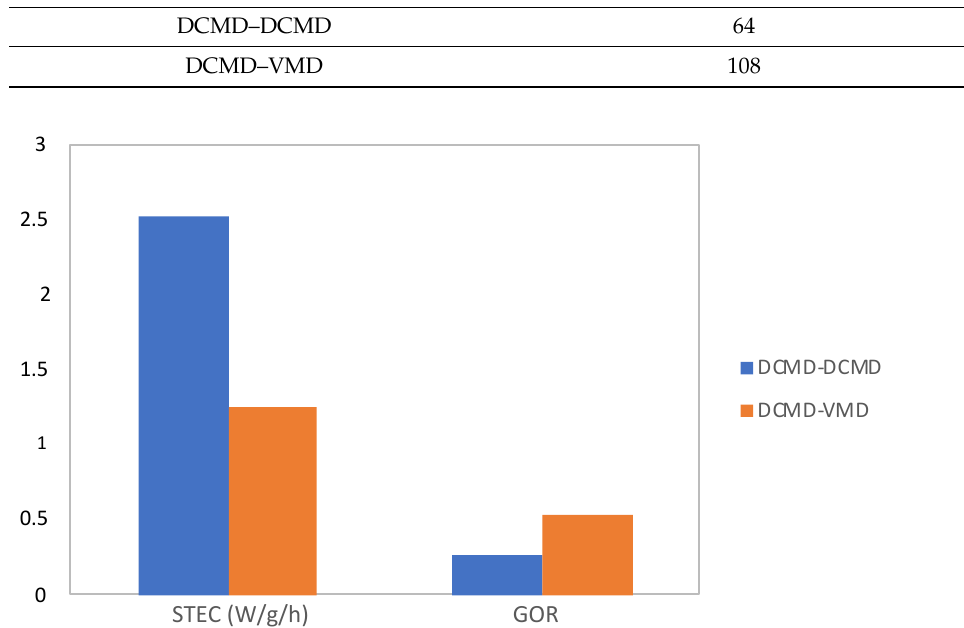
Figure 11. Comparison between the flowsheet with the DCMD units in series and the integrated DCMD–VMD flowsheet in terms of STEC and GOR.